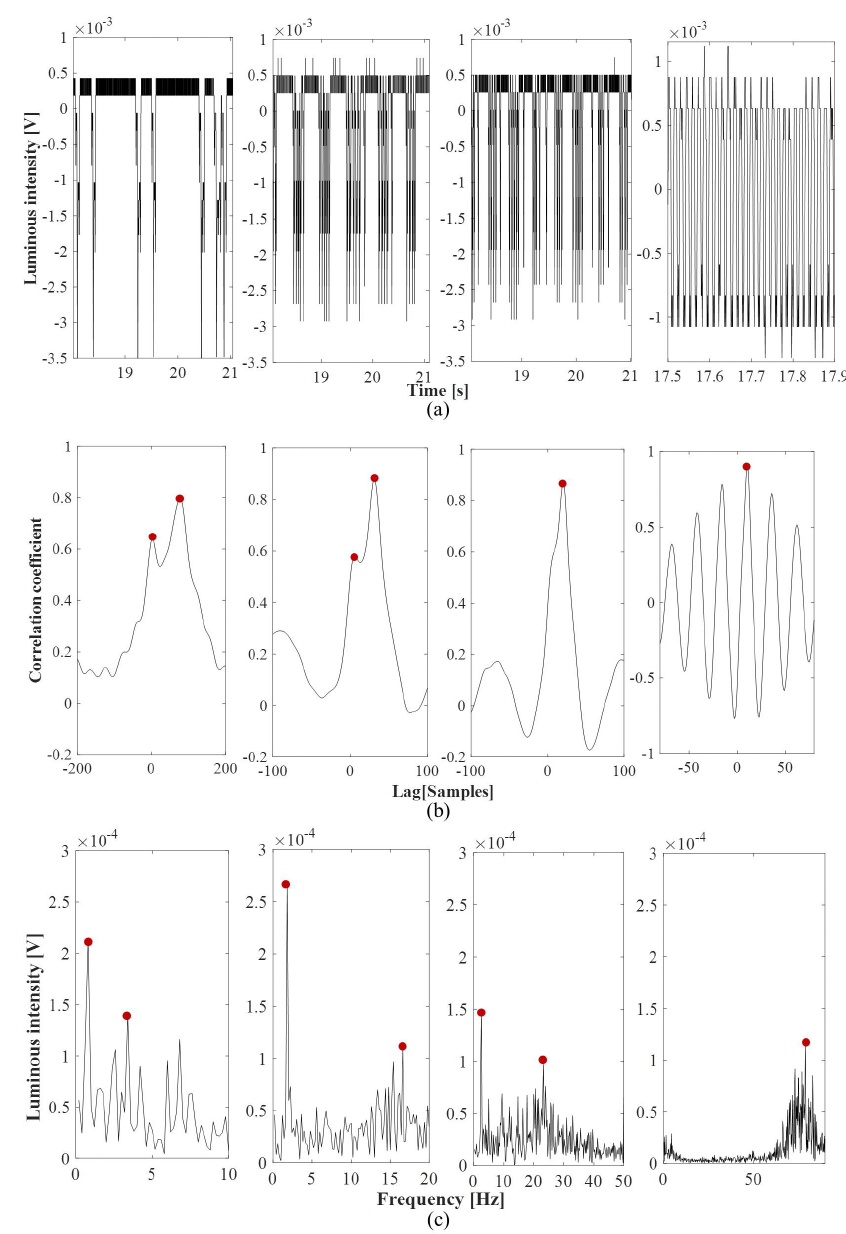
Figure 4. Dynamics of the slug flows in the experiments F ∈ { 0.2,0.4,0.6,0.9 } mL/min. ( a ) the trends of the raw optical signals acquired varying the input flow rate. The change of the flow patterns from long water slugs is evident interlaced by short air slugs one after another ( F = 0.2 mL/min), to longer water slugs ( F = 0.4–0.6 mL/min) followed by a train of smaller air/water passages and finally a train of smaller water/air slugs ( F = 0.9 mL/min); ( b ) the cross-correlation between the signals acquired through the two photo-diodes, and in red dots the peaks detected; ( c ) the spectra of the optical signal { ph 2 } , and in red dot the peaks